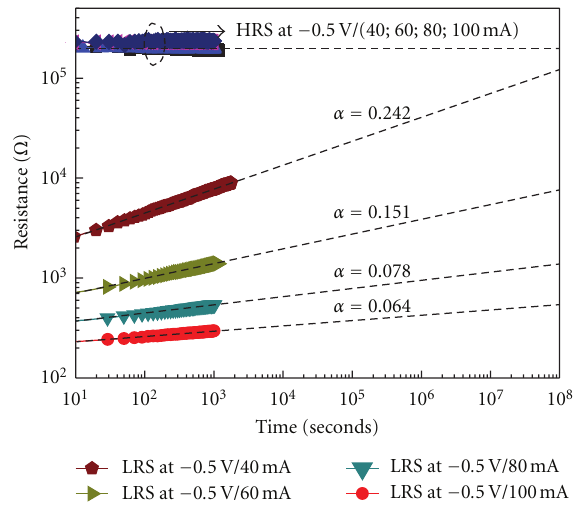
Figure 7: Resistance relaxation of the NiO/NSTO heterojunction with time after switching to LRSs and HRSs by +5V or − 5V with di ff erent compliance